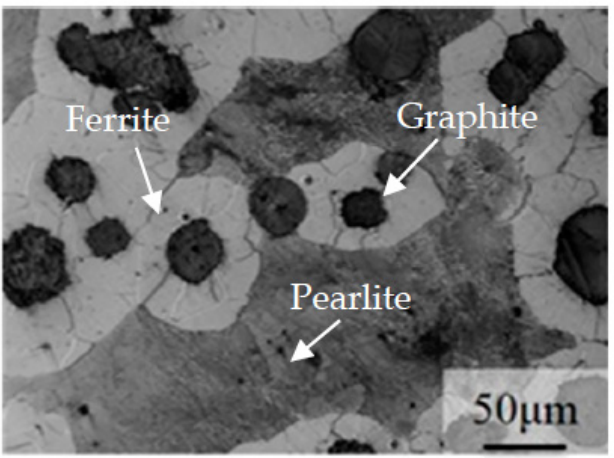
Figure 2. Microstructure of the ductile iron.